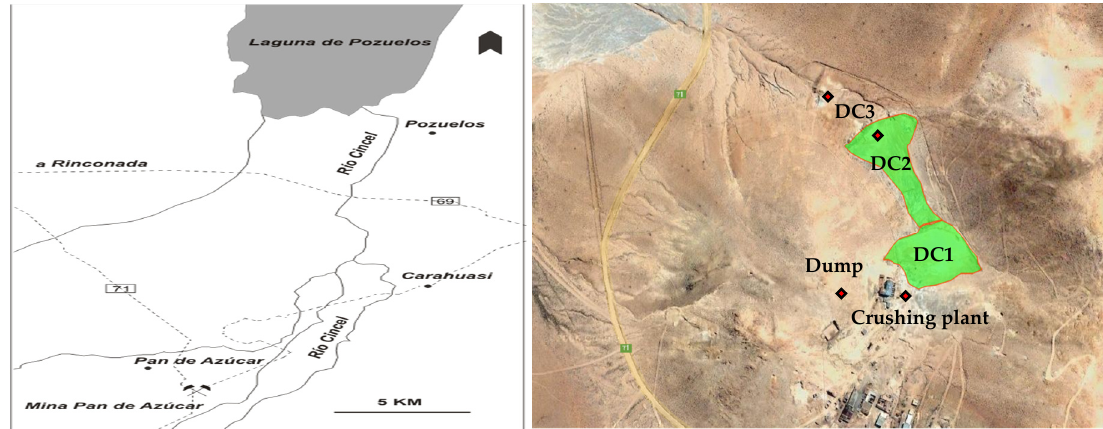
Figure 1. Location of Pan de Azúcar mine and Laguna Pozuelos ( left ); magnified view of the tailings dams in the area (right). The sampling points ( ) are indicated in the last view.